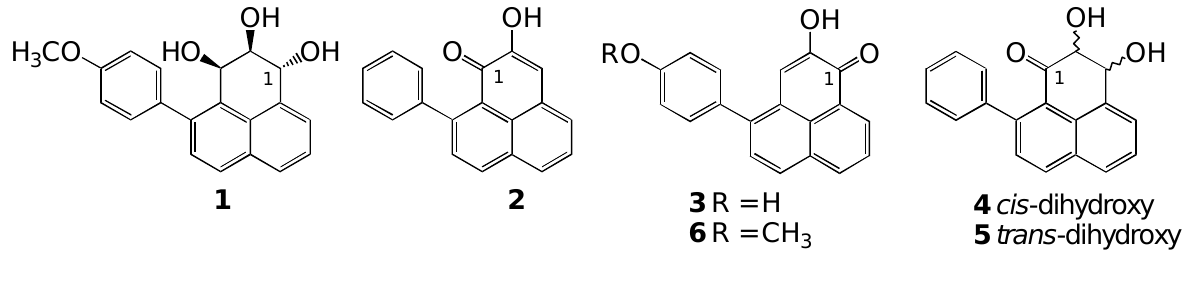
Figure 1. Phenylphenalenone